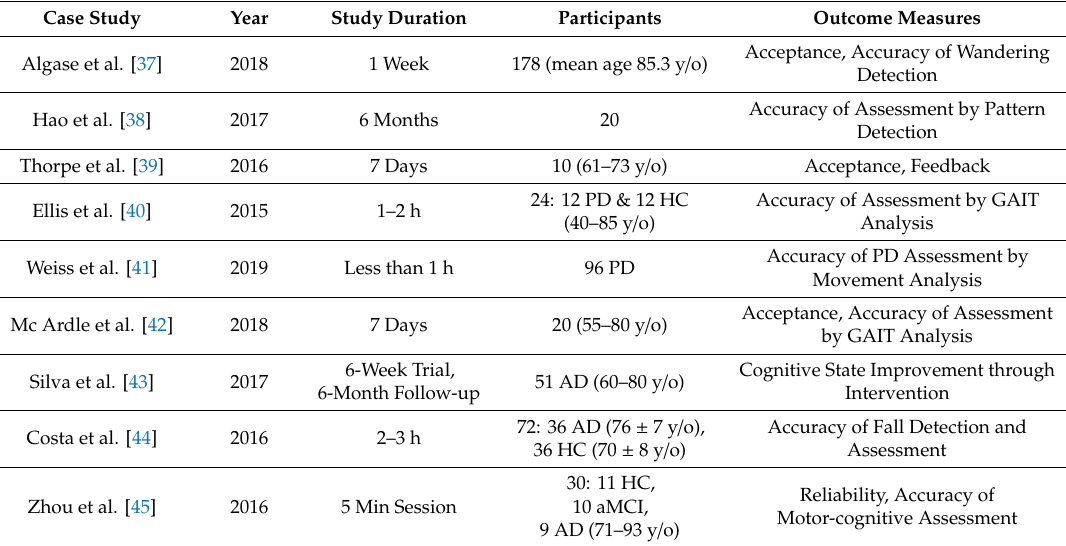
Table 3. Review of case studies with evaluation and their aspects. MCI, mild cognitive